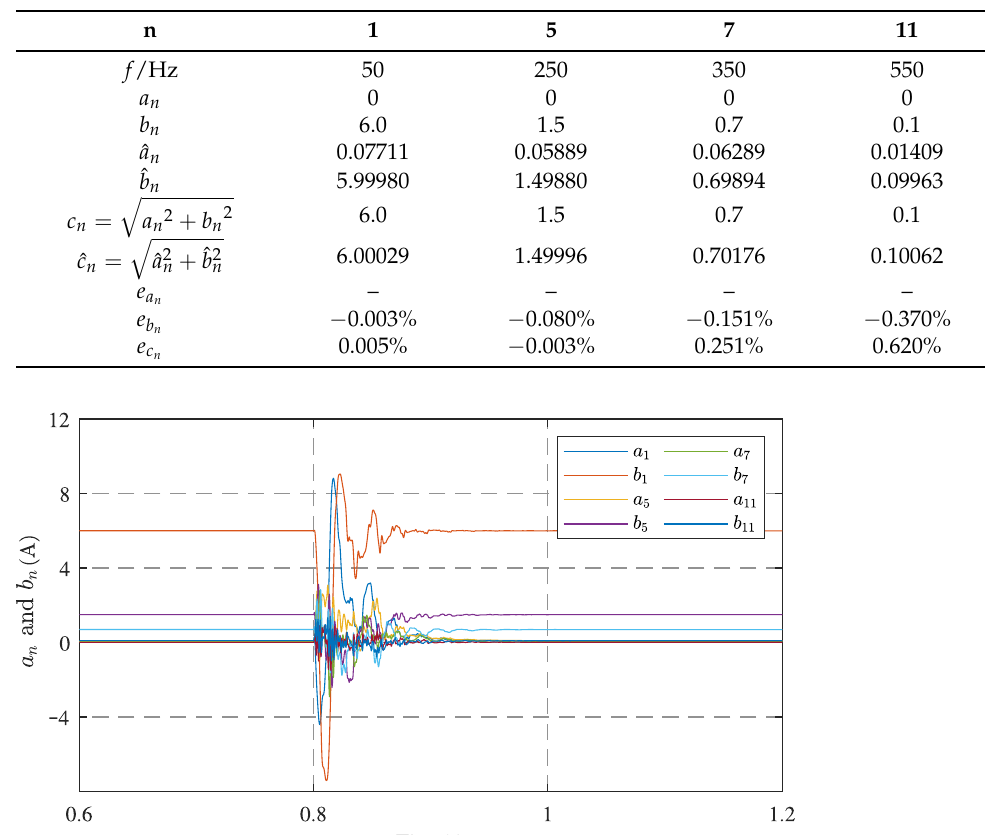
Table 2. Parameters comparison.